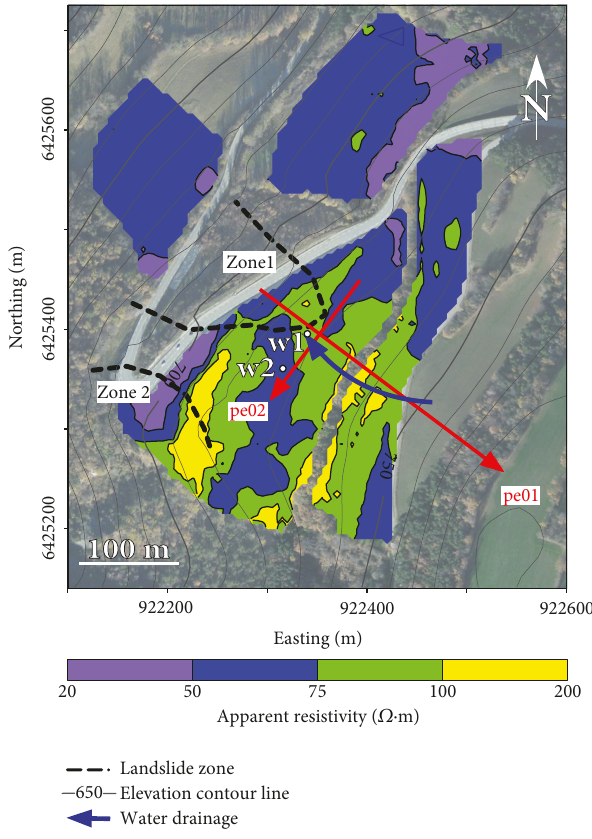
Figure 3: Map of the apparent resistivity over the fi rst 5 m. The blue arrow represents a possible preferential water drainage path. The location of water in fi ltration tests w1 and w2 is indicated. The location of resistivity pro fi les pe01 and pe02 is indicated by red arrows.